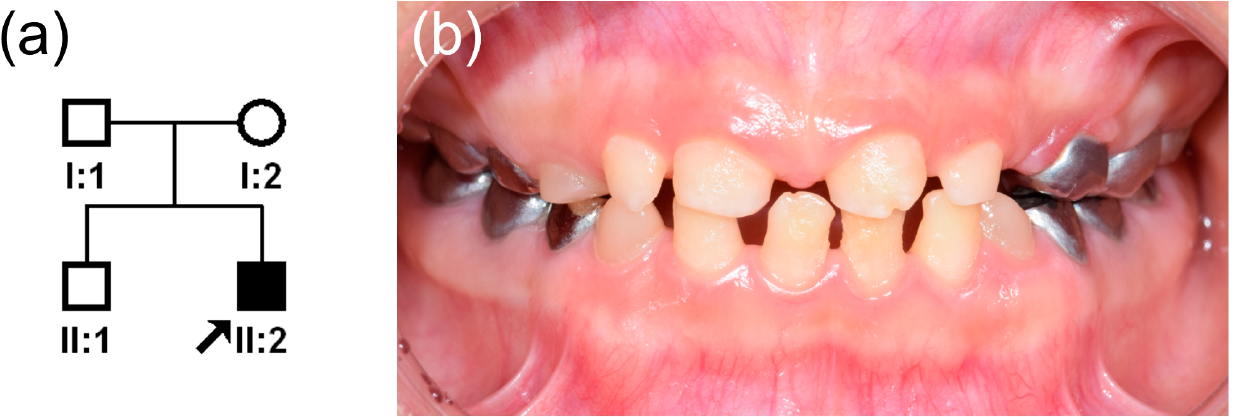
Figure 1. ( a ) Pedigree of the study family. The black arrow denotes the proband. ( b ) Clinical photo of the central occlusion of the proband taken at age 9 years 9 months. Hypoplastic enamel resulted in small and misshapen anterior permanent teeth with wide interdental spacing.